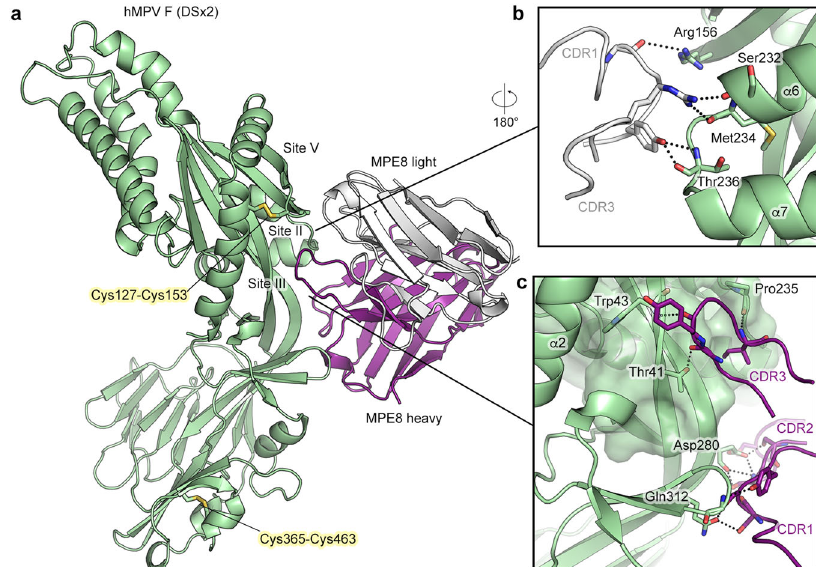
Fig. 4 Crystal structure of engineered hMPV F variant DSx2 bound to antibody MPE8. a Side view of the atomic model of hMPV F variant DSx2 bound to MPE8 Fab, shown as ribbons. The F protomer is colored green, the heavy chain of MPE8 is colored purple and the light chain of MPE8 is colored white. The constant region of MPE8 Fab is omitted for clarity. Side chains of two disul fi de substitutions in DSx2 are highlighted as sticks. b Zoomed view of the binding interface of the MPE8 light chain CDRs and F antigenic sites II and V. c Zoomed view of the binding interface of the MPE8 heavy chain CDRs and F. Main chain atoms of H-CDR3 pack against antigenic site III, which is highlighted as a transparent surface. Key residues that form polar interactions are shown as sticks.